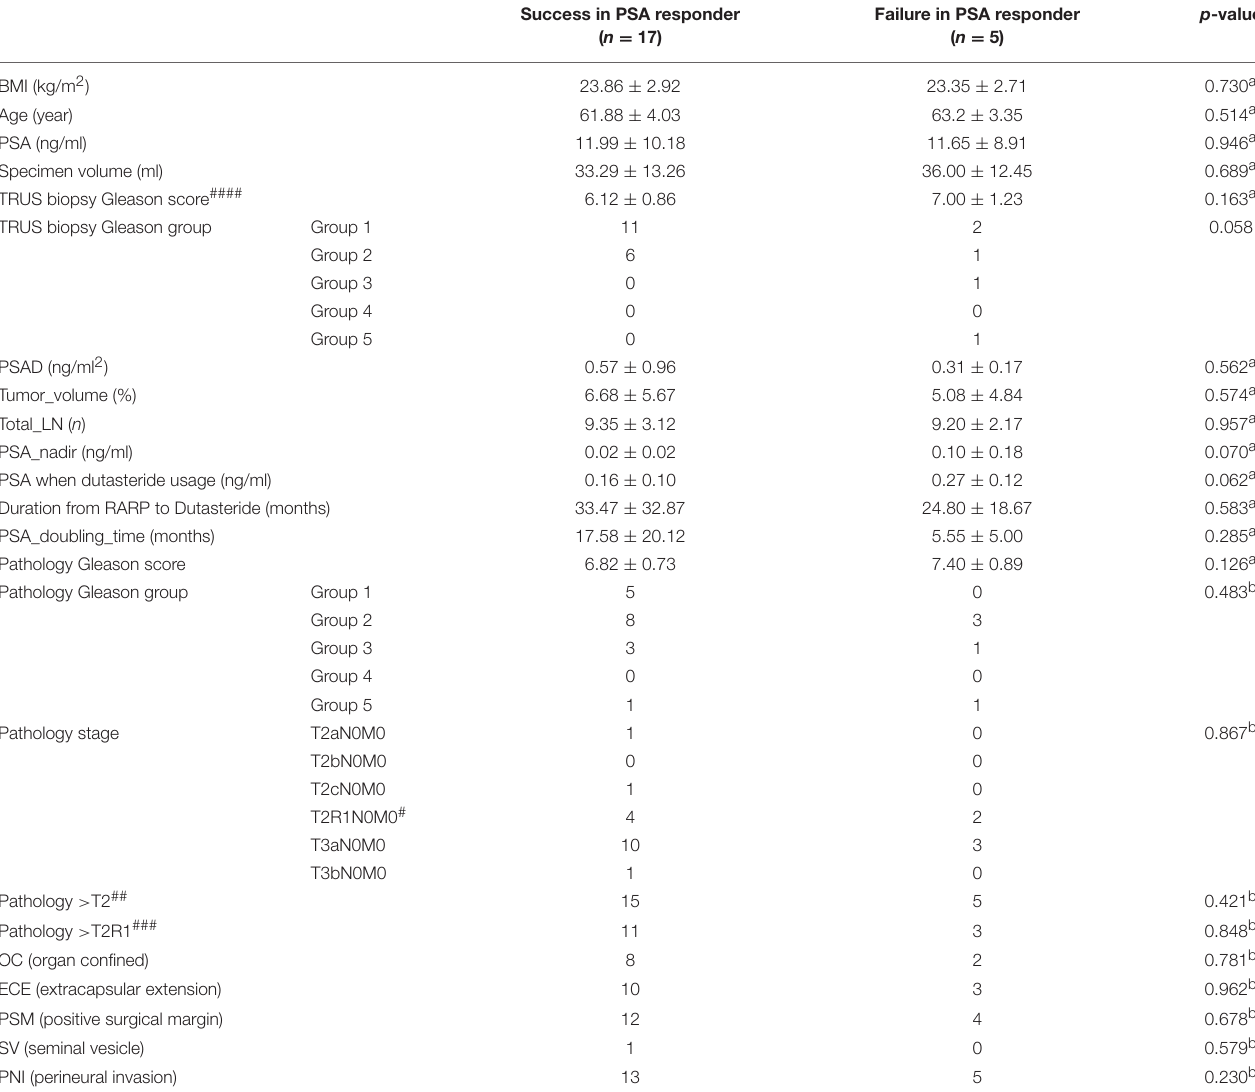
TABLE 2 | Comparison of clinicopathological variables of success with failure in